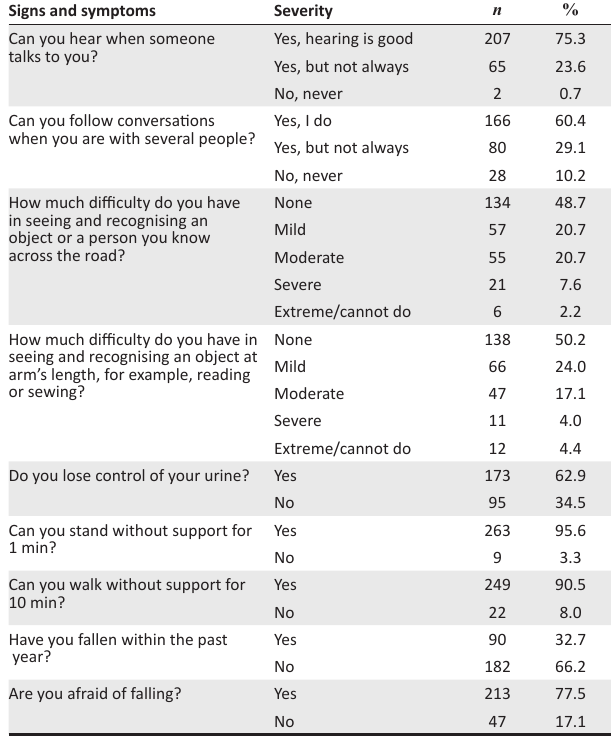
TABLE 2 : Services available at the service centres for older persons ( n = 25). Available programmes